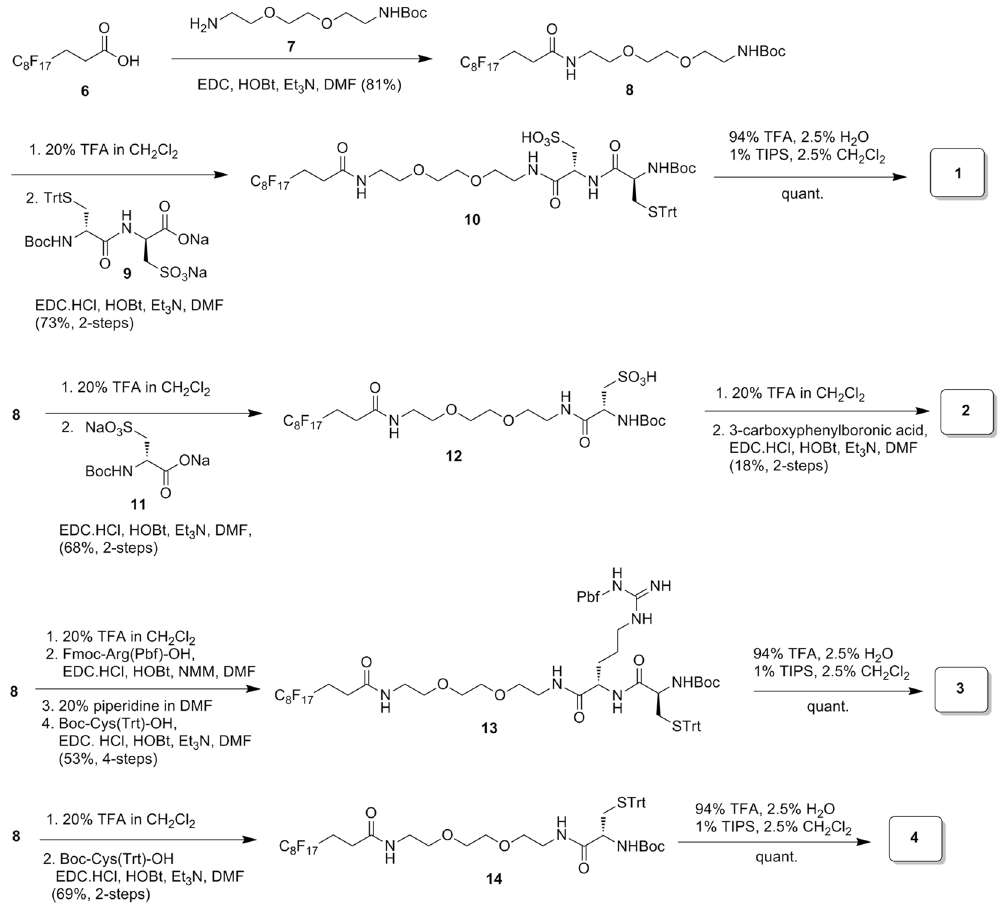
Figure 2. Synthesis of probes 1–4